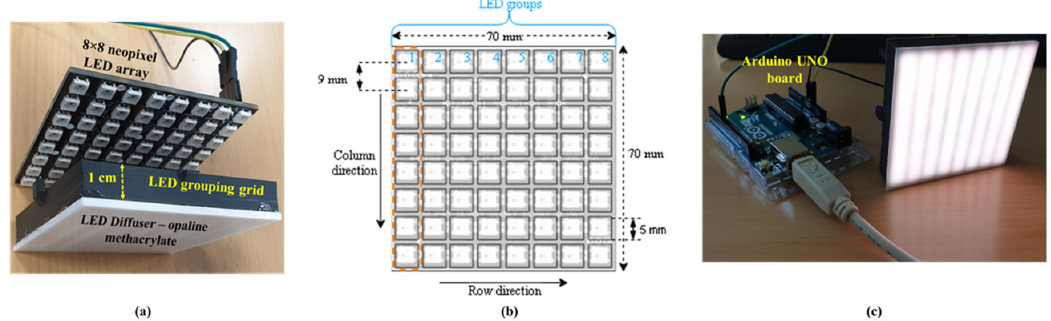
Figure 1. The transmitter (Tx) unit: ( a ) assembled unit with the grid and a diffuser, ( b ) an LED array configuration and ( c ) an Arduino Uno controller board and the LED panel.